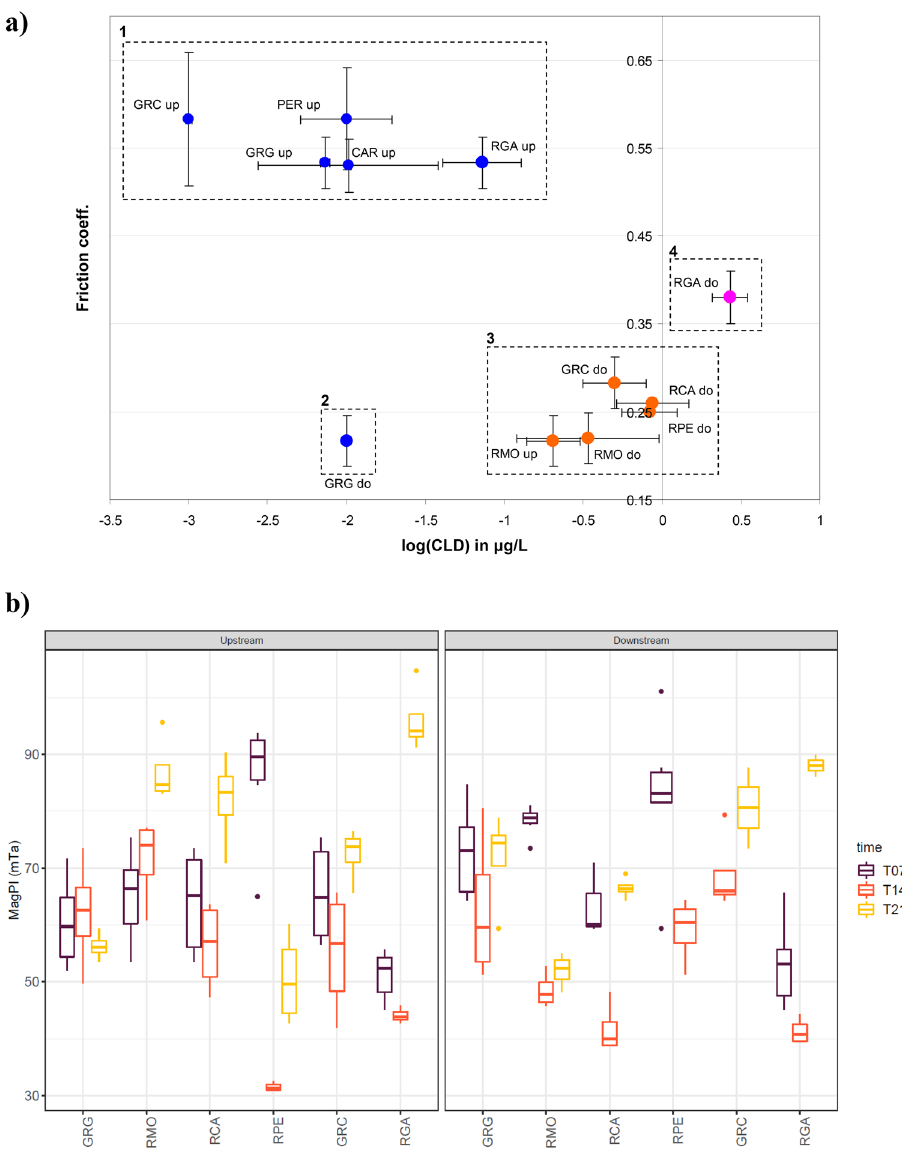
Figure 4. ( a ) The friction coefficient related to the CLD contamination, the same color codes as Fig. 1b are employed, identifying the three contexts of pollution, ( b ) Surface adhesiveness of upstream (left panel) and downstream (right panel) epilithic biofilms measured by Magnetic Particle Induction (MagPI). Sampling sites were ordered from the least polluted to the most polluted according to the order given in Fig. 1b for downstream